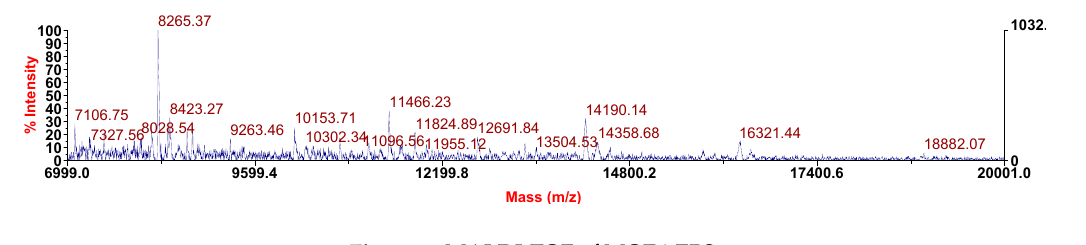
Figure 6. MALDI-TOF of MOE6-EPS.